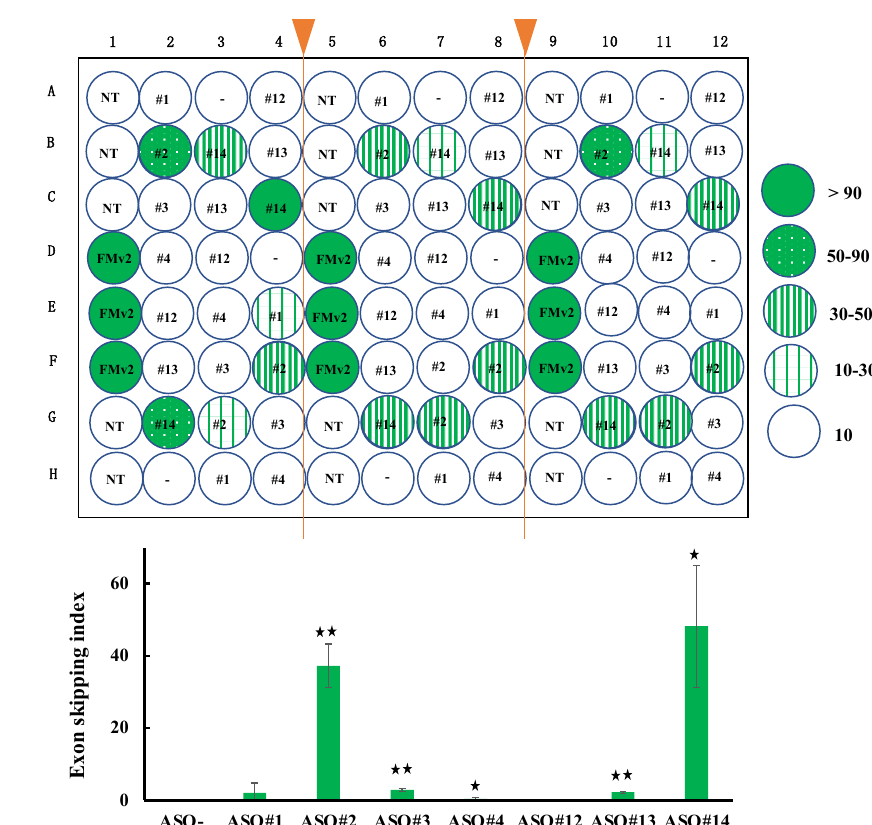
Figure 5. Application of FMv2 CD44 v8 for high throughput screening of exon skippable ASO. ( A ) To examine the applicability of FMv2 CD44 v8 for high throughput screening, a 96 well plate was separated into three parts and seeded with HeLa cells. After transfection of FMv2 CD44 v8, seven di ff erent ASOs were randomly and blindly added to the culture medium. Fluorescence was analyzed in each well and the exon skipping index was calculated after the construction of histograms. The index of each well is shown by a color; wells with less than 10, 10–30, 30–50, 50–90, and more than 90 of the index are illustrated by open, plaid green, vertical stripe green, dotted green and dark green circles, respectively. In the center of the circles, the corresponding ASO is indicated. NT denotes non-transfection of minigenes. In three separated regions, the wells with identical treatment disclosed similar index values. This indicated that multiple samples can be analyzed simultaneously. ( B ) The exon skipping index was summarized to reveal ASO-specific activity. The mean values are shown by vertical columns with error bars. Significant di ff erences were detected by comparing the wells with the indicated ASOs and wells without ASO (ASO-) (* p < 0.05 and ** p <